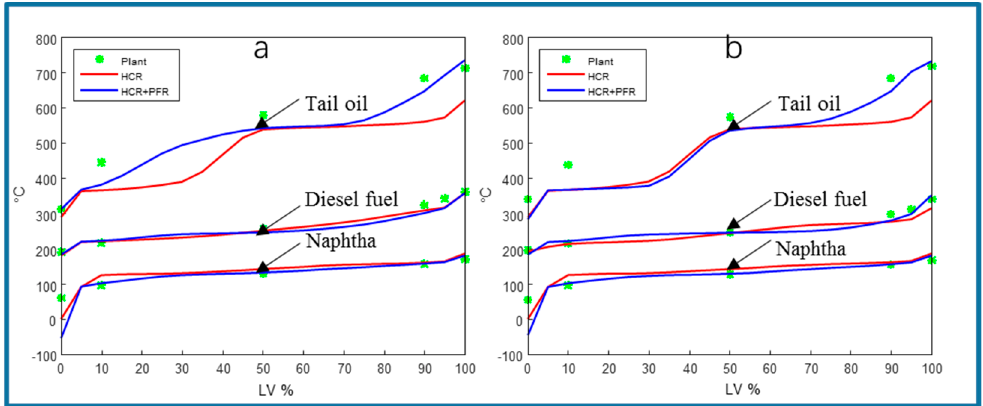
Figure 9. Predictions of the ASTM D86 distillation curves of liquid products with the HCR model and HCR + PFR model: ( a ) Dataset 1; ( b ) Dataset 3. Table 5. Comparison of the prediction average relative deviations of boiling point for tail oil with the HCR model and HCR + PFR model. Dataset 1 Dataset 2